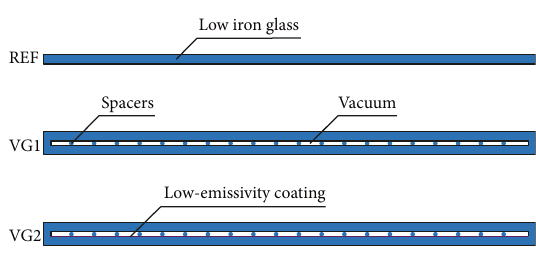
Figure 3: Con fi gurations of the investigated cover glazings. Table 1: Comparison of cover glazing physical properties. Properties